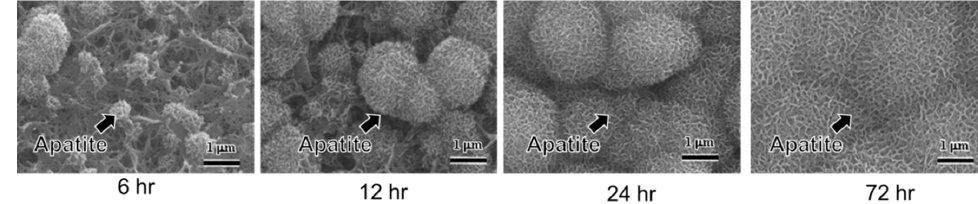
Figure 1. Apatite formation and growth on the surface of Ti subjected to NaOH and heat treatment by soaking in in simulated body fluid (SBF) (reproduced from [15]). The needle-like shape of bone-like apatite nanocrystals can be appreciated.